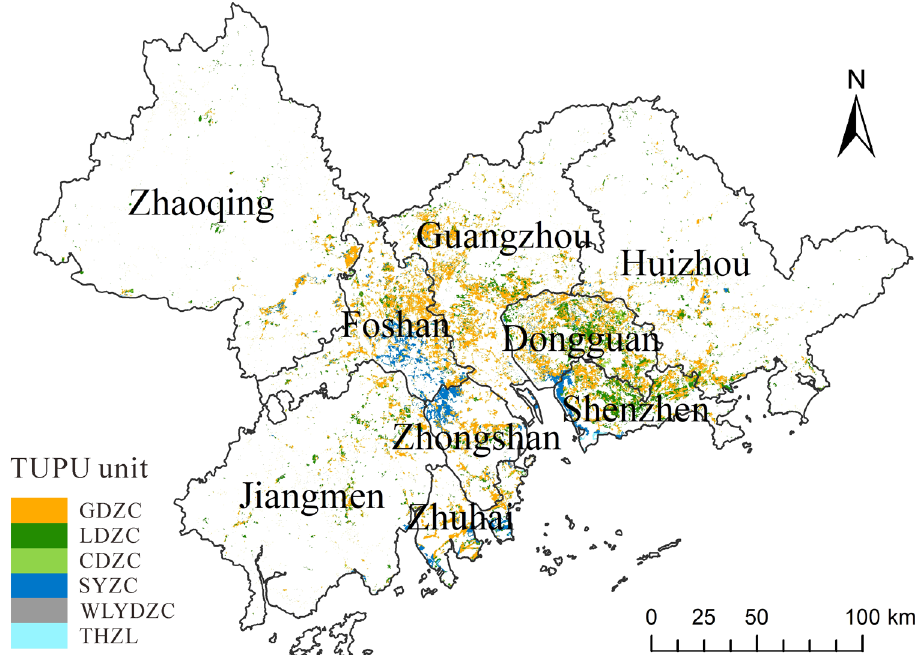
Figure 4. Map of construction land growth from 1990 to 2018. GDZC, decreased cultivated land; LDZC, decreased forest land; CDZC, decreased grassland; SYZC, decreased water; WLYDZC, decreased unused land; THZL, decreased ocean.